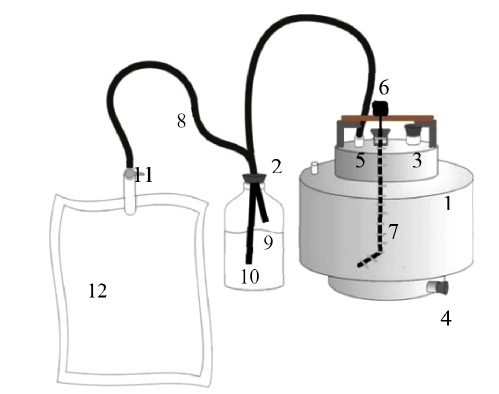
Figure 1. Continuous experimental set up (Saputra et al.,